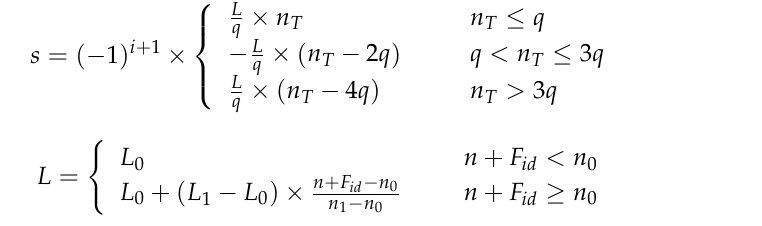
Figure 7. Verification of calculation accuracy of rolls-strip integrated model.